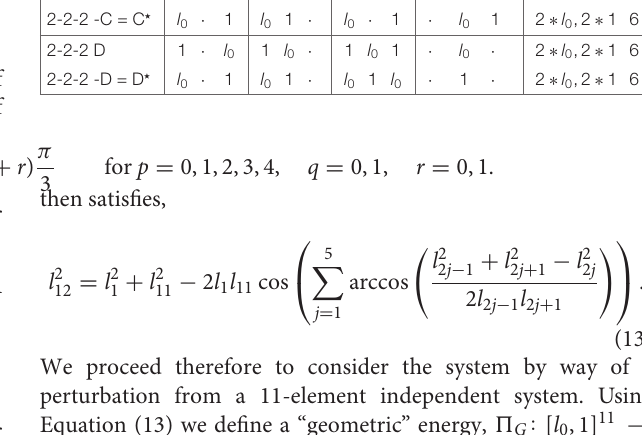
FIGURE 10 | Example hexagon configurations (A) 3-0-3, here l 0 the inverse golden ratio, so φ consecutive angles add up to π so geometrically there are three straight lines